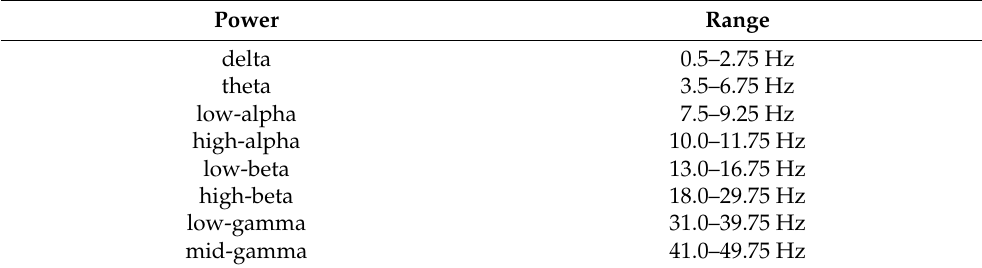
Figure 4. GUI of the low-cost biofeedback platform developed in this study. Table 4. EEG powers derived from NeuroSky